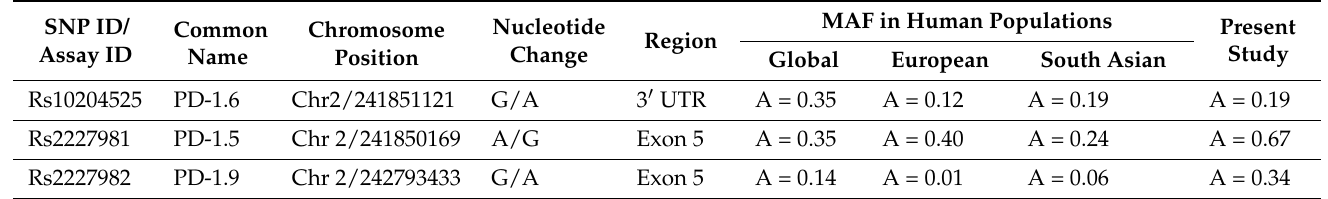
Table 2. Characteristics of selected polymorphisms involved in PD-1 gene receptor